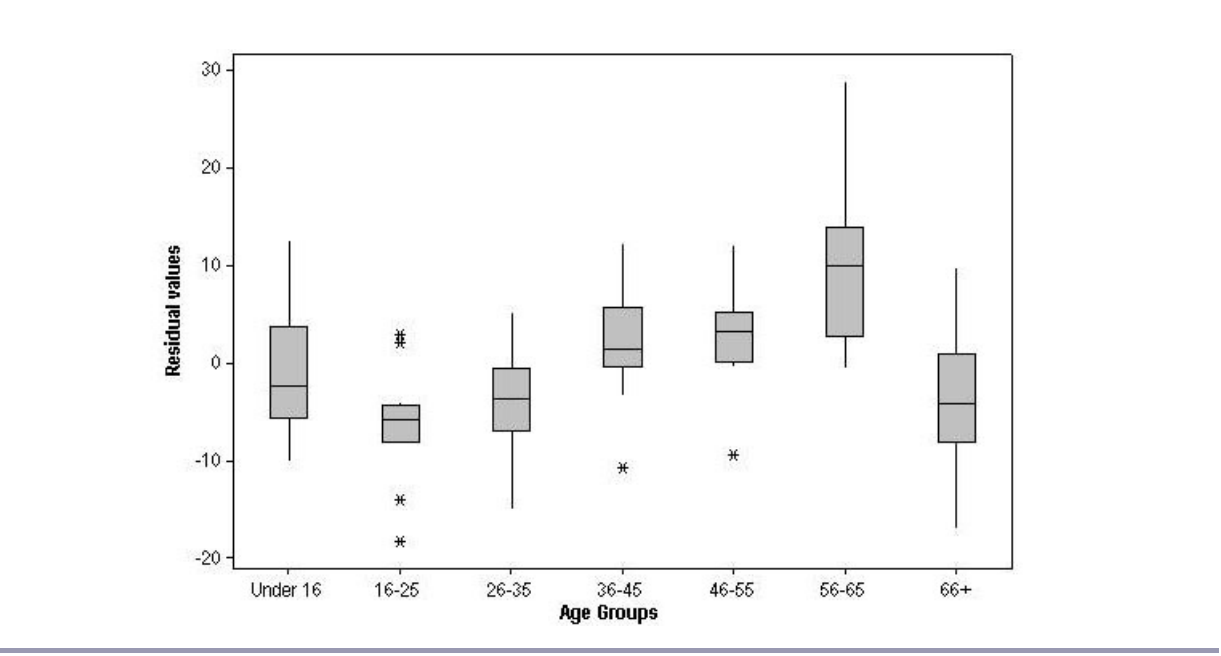
Fig. 4 . Residuals of age groups for